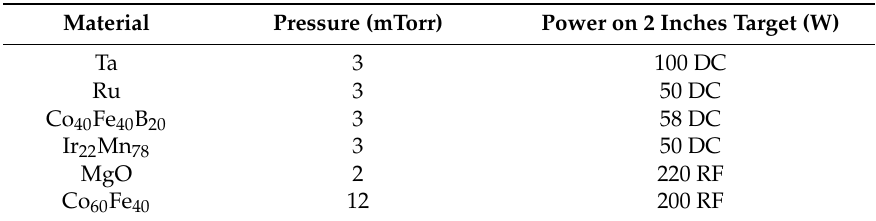
Table 1. Sputtering deposition